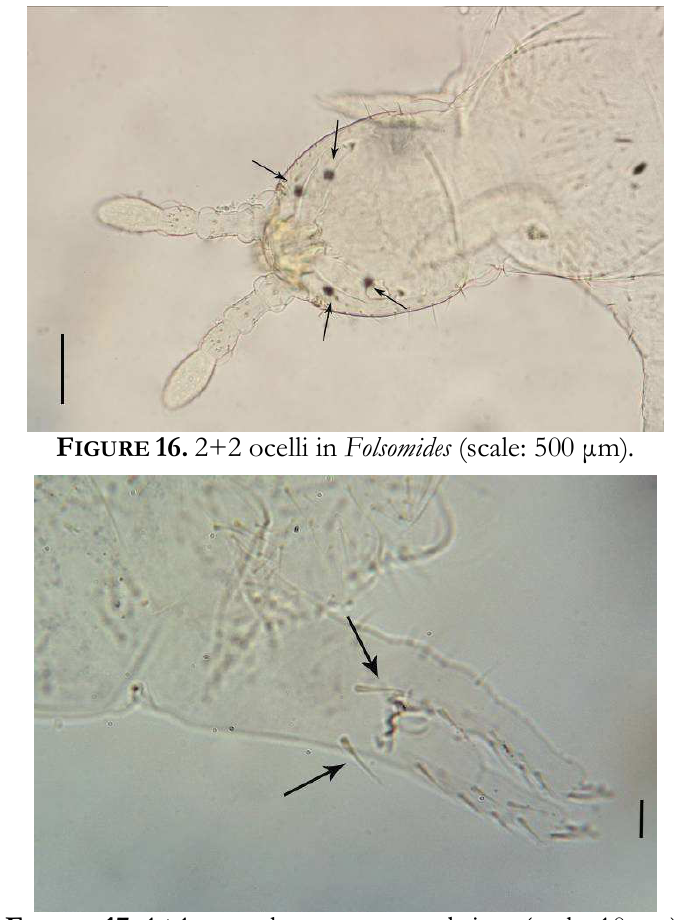
F IGURE 17. 1+1 ventral setae on manubrium (scale: 10 µm)